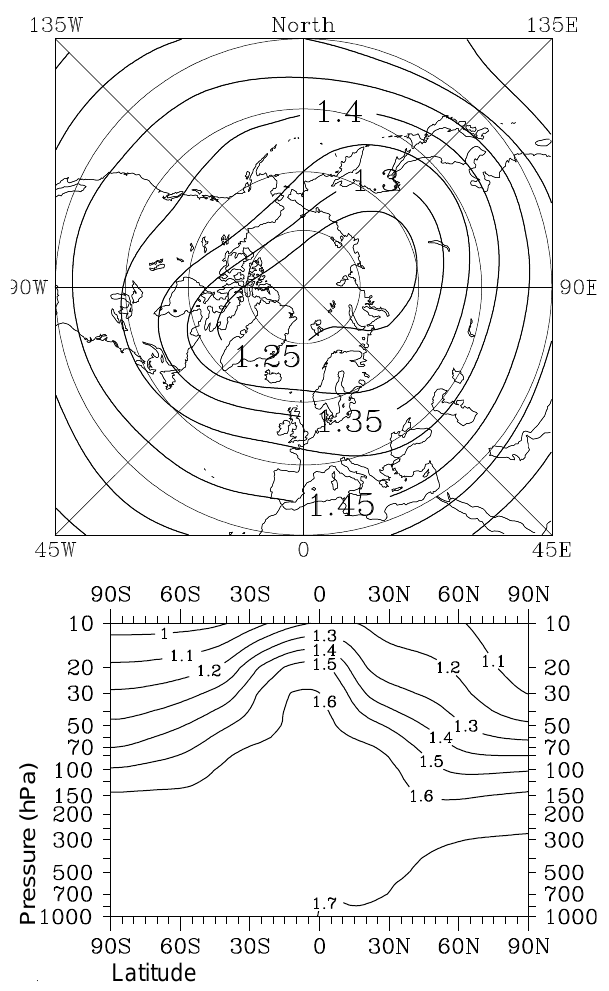
Fig. 6. Modeled methane mixing ratio in February, averaged over 20 simulated years; top: in the northern stratosphere at 50 hPa, contour lines are 1.1, 1.15, 1.2, ... , 1.6 ppmv; bottom: zonal mean height cross section (in